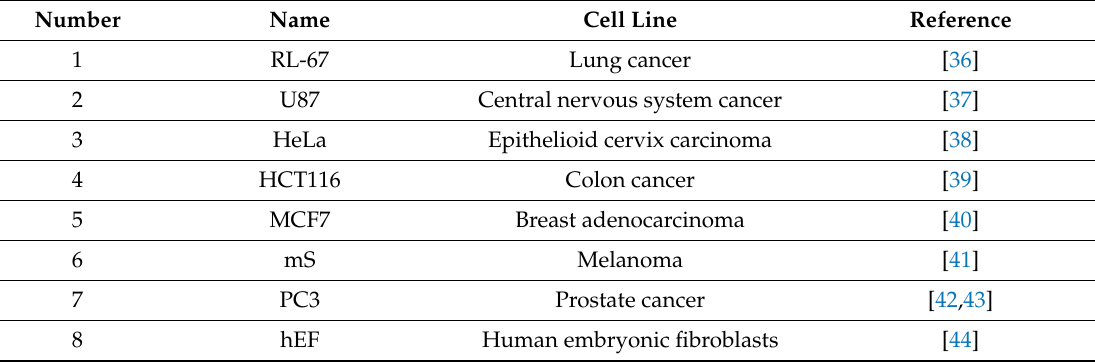
Table 3. List of the human cancer cell lines and the control cell